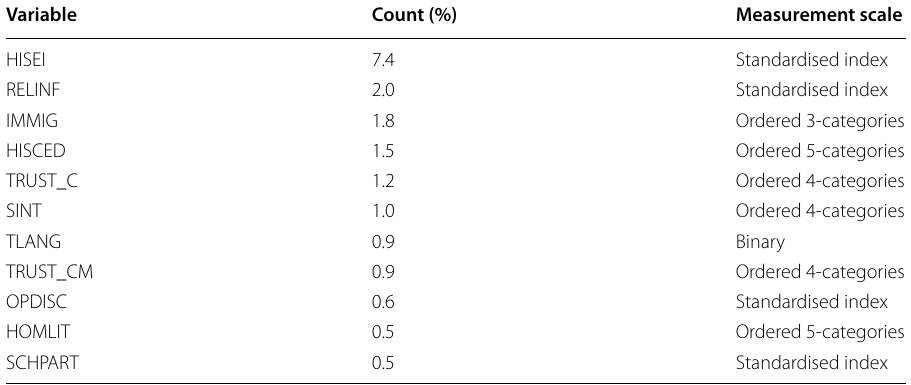
Table 7 Structure of missing data